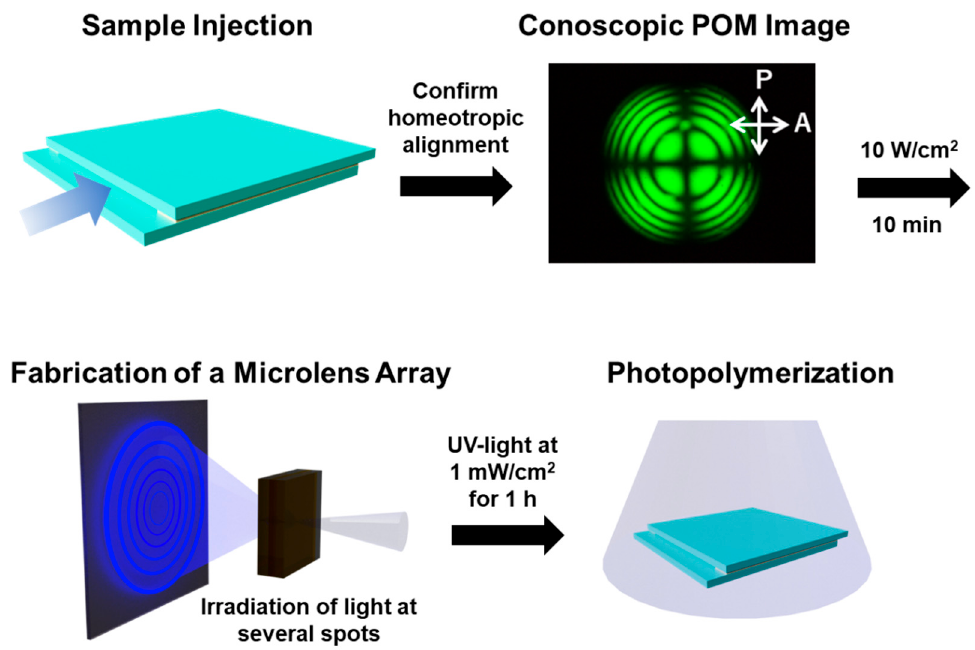
Figure 3. Experimental procedure used to fabricate a microlens array embedded in a polymer net- work.